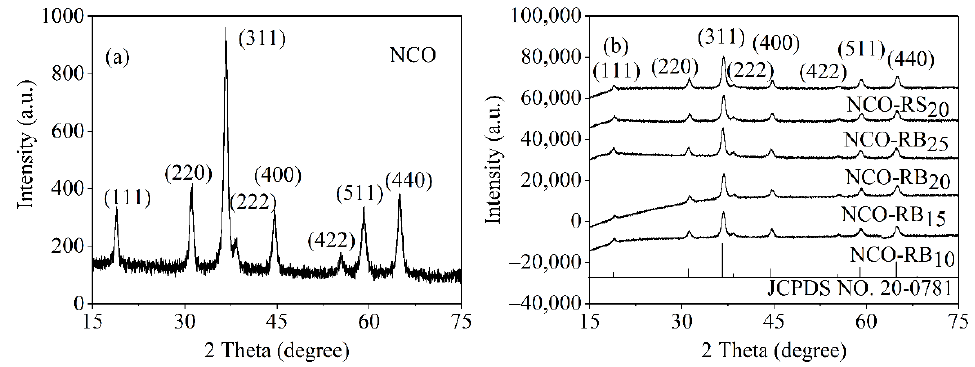
Figure 1. X-ray diffraction (XRD) spectra of NCO ( a ) and modified NCO ( b ), NCO-RB n refers to the catalyst obtained by NCO being etched by n mmol/L NaBH 4 solution (n is 10, 15, 20, or 25); NCO-RS 20 refers to the catalyst obtained by NCO being etched by 20 mmol/L Na 2 SO 3 solution. Table 1. The specific surface area (SSA), total pore volume (VT), and average pore diameter (APD), crystallite size, and Ni/Co atomic ratio of the origin NCO prepared in this work, and the modified NCO which were prepared by the solution of NaBH 4 (10 mmol/L, NCO-RB 10 ; 15 mmol/L NCO-RB 15 ; 20 mmol/L, NCO-RB 20 ; 25 mmol/L, NCO-RB 25 ) or Na 2 SO 3 (20 mmol/L, NCO-RS 20 ) etching. Catalyst a SSA (m 2